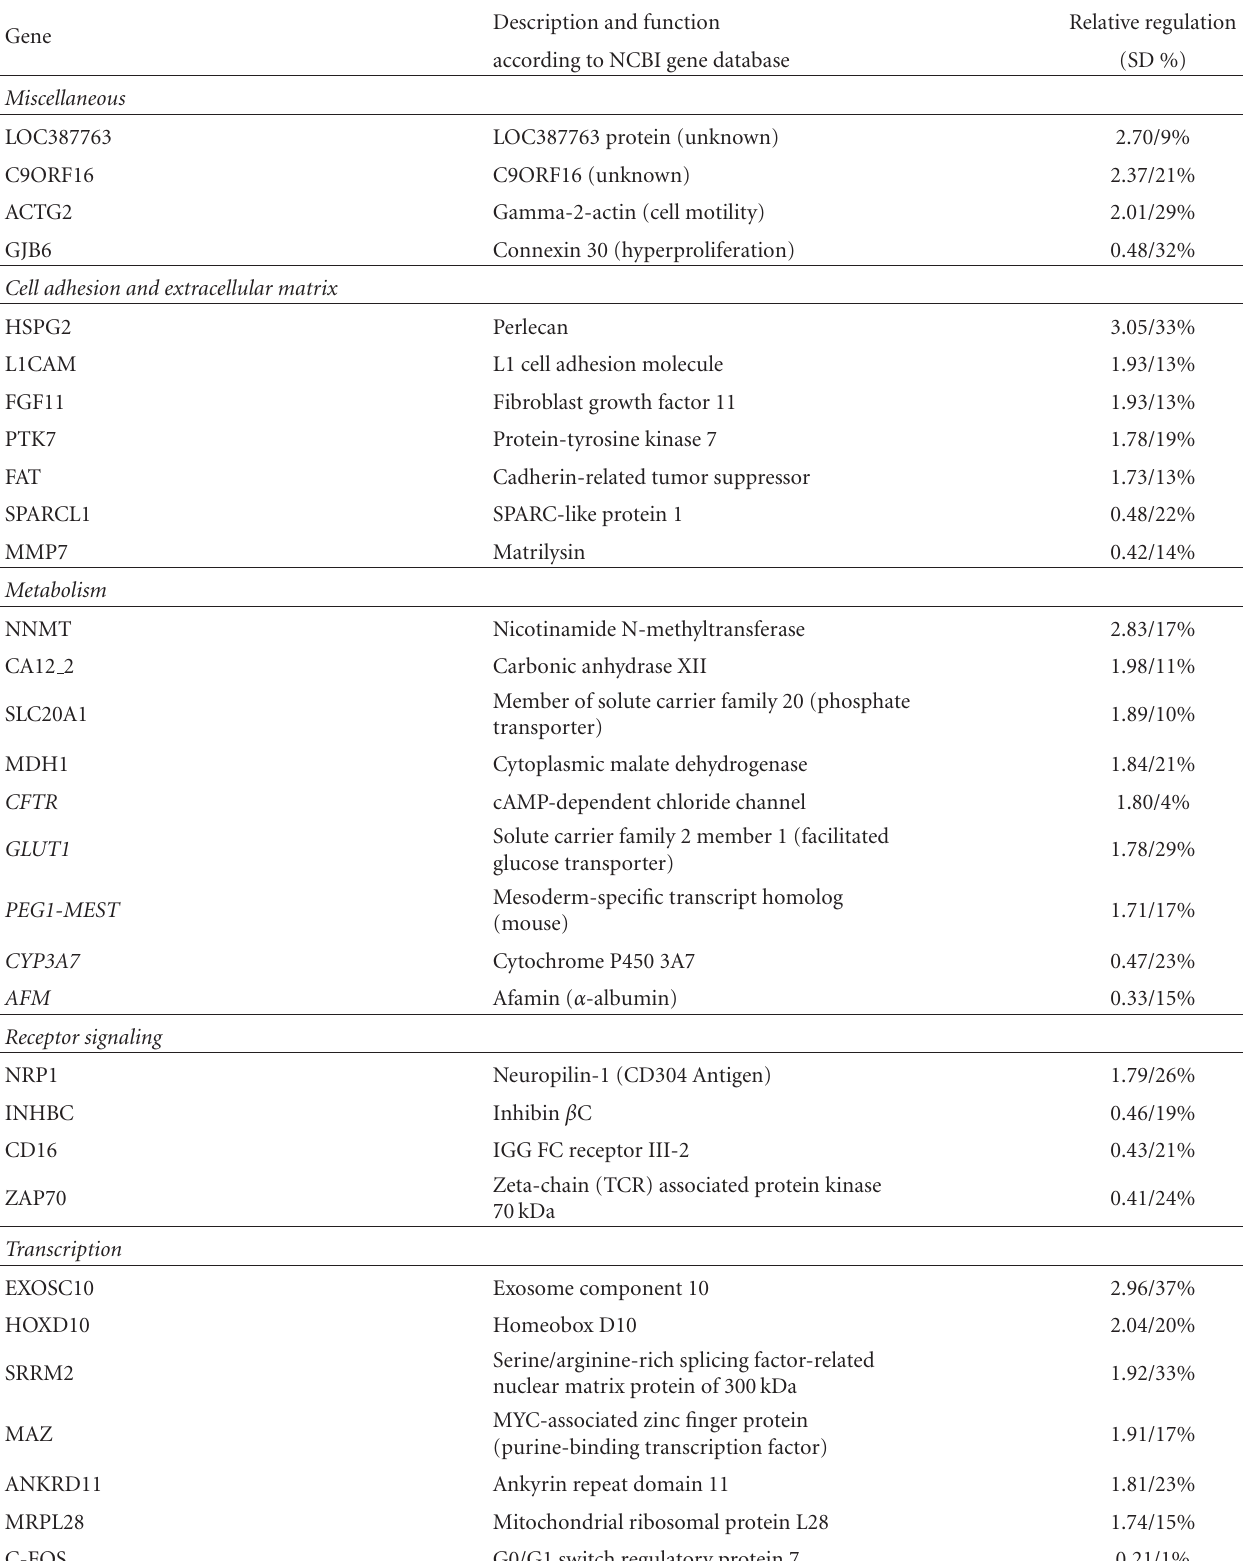
Table 6: Summary of genes with significantly changed expression ( > 1.7, < 0.5) from 1308 genes in total within gene expression analysis using topic-defined PIQOR skin microarray (Miltenyi Biotech, Cologne, Germany) from NHDF after treatment with polysaccharides